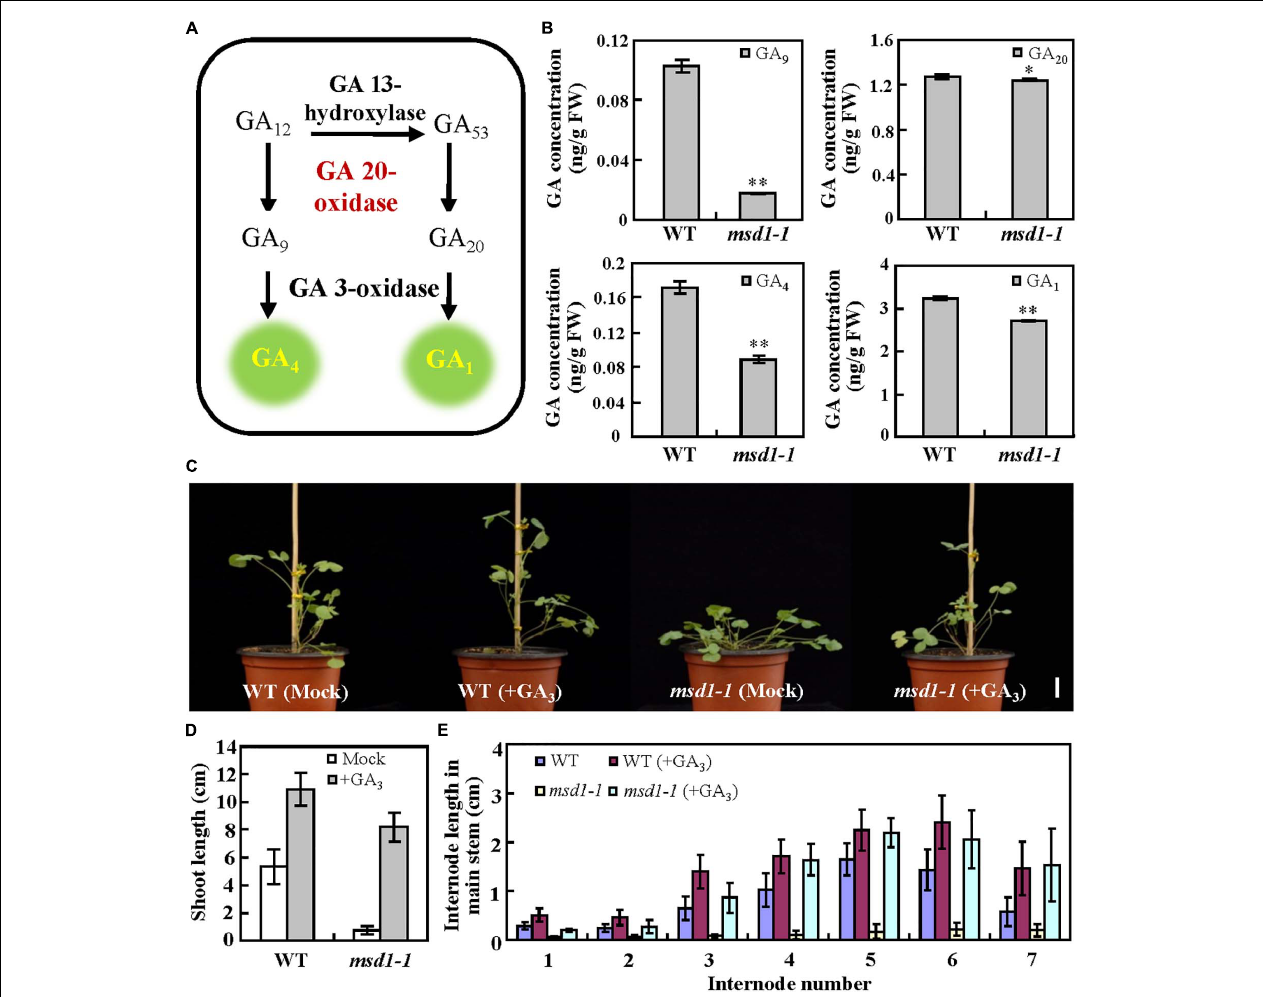
FIGURE 3 | MSD1 was involved in GA biosynthesis pathway. (A) Simplified scheme of the later steps in GA biosynthesis pathway. (B) Concentrations of endogenous GA 9 , GA 20 , GA 4 , and GA 1 in 5-week-old WT and msd1-1 plants. Bars represent means ± SD ( n = 3); asterisks indicate significant differences from the WT ( ∗ P < 0.05, ∗∗ P < 0.01, Student’s t- test). (C) Phenotypes of wild type (WT) and msd1-1 mutant treated with 2 mM GA 3 for 5 weeks in comparison with untreated controls (mock). Bars = 2 cm. ( D ) The main shoot height of plants in the experiment shown in panel (C) . Bars represent means ± SD ( n = 16). (E) The internode length in main stem in the experiment shown in panel (C) . Bars represent means ± SD ( n =